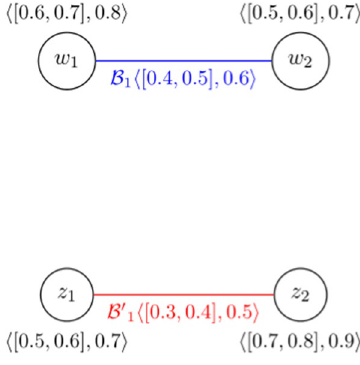
Fig. 5 Strong CFGS G ∗ G � = ( 𝔄 , 𝔅 1